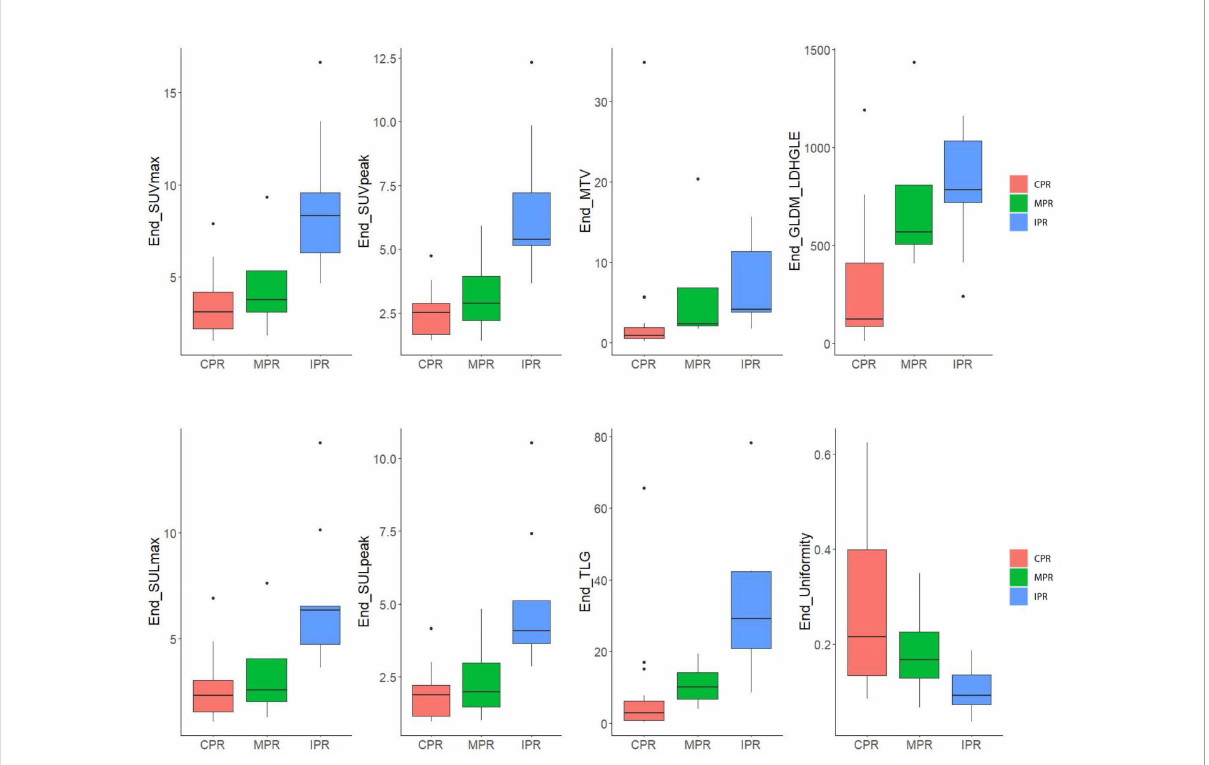
FIGURE 5 Box plot for six SUV statistics features and two radiomics features of preoperative PET of 29 patients. The red box represents the complete pathological response (CPR) group. The green box represents the major pathological response (CPR) group. The blue box represents the incomplete pathological response (IPR) group. Lengths of whiskers are limited to a maximum of 1.5 times the interquartile range. Box indicates the interquartile range around the